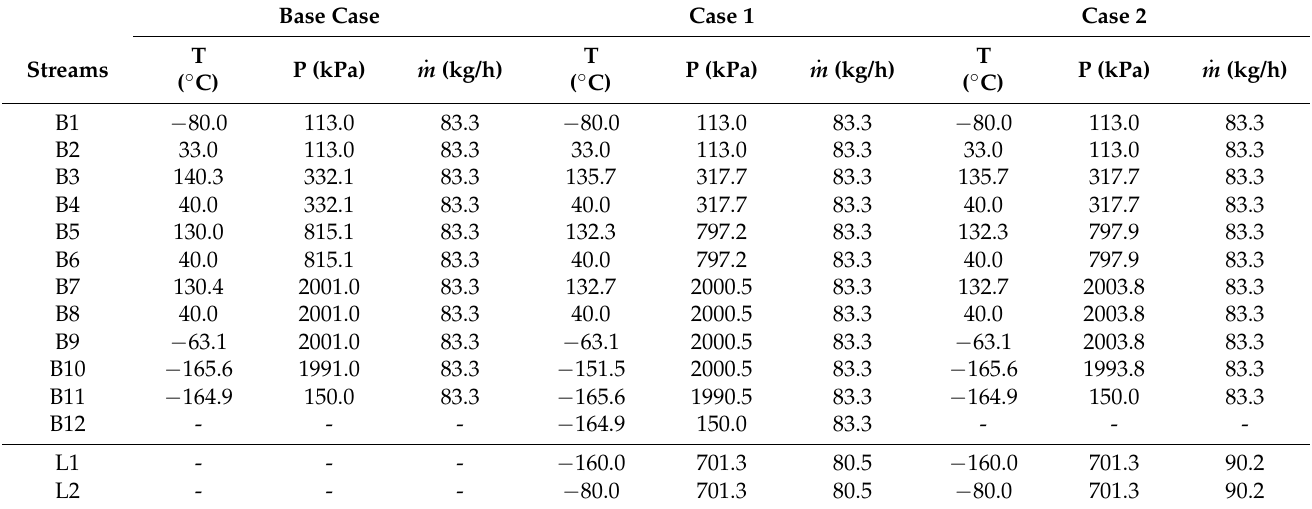
Table 5. Thermodynamic parameters of BOG and LNG streams in the optimized